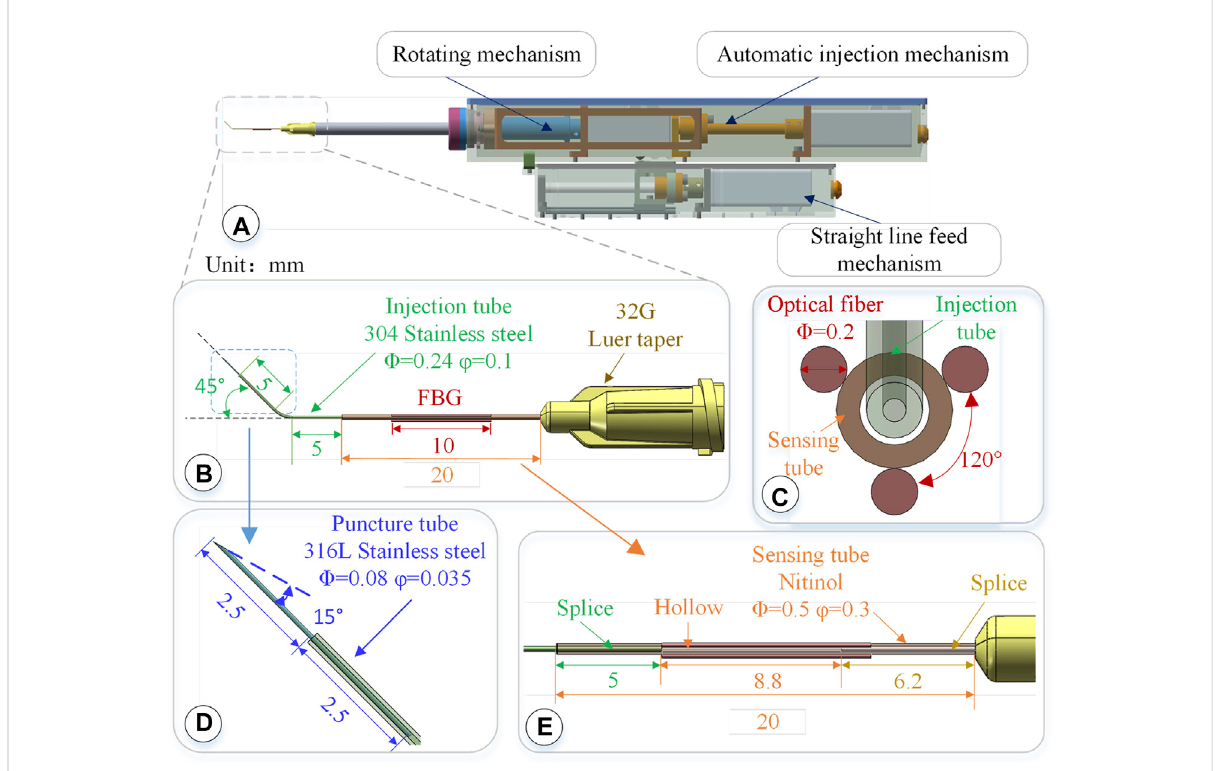
FIGURE 2 3-DOF micro-force-sensing medicine injection device. (A) 3-DOF micro-force-sensing medicine injection device driving mechanism. (B) 3- DOF micro-force-sensing sleeve needle. (C) FBG sensor cross section array layout. (D) Puncture needle. (E) FBG sensor axial direction layout